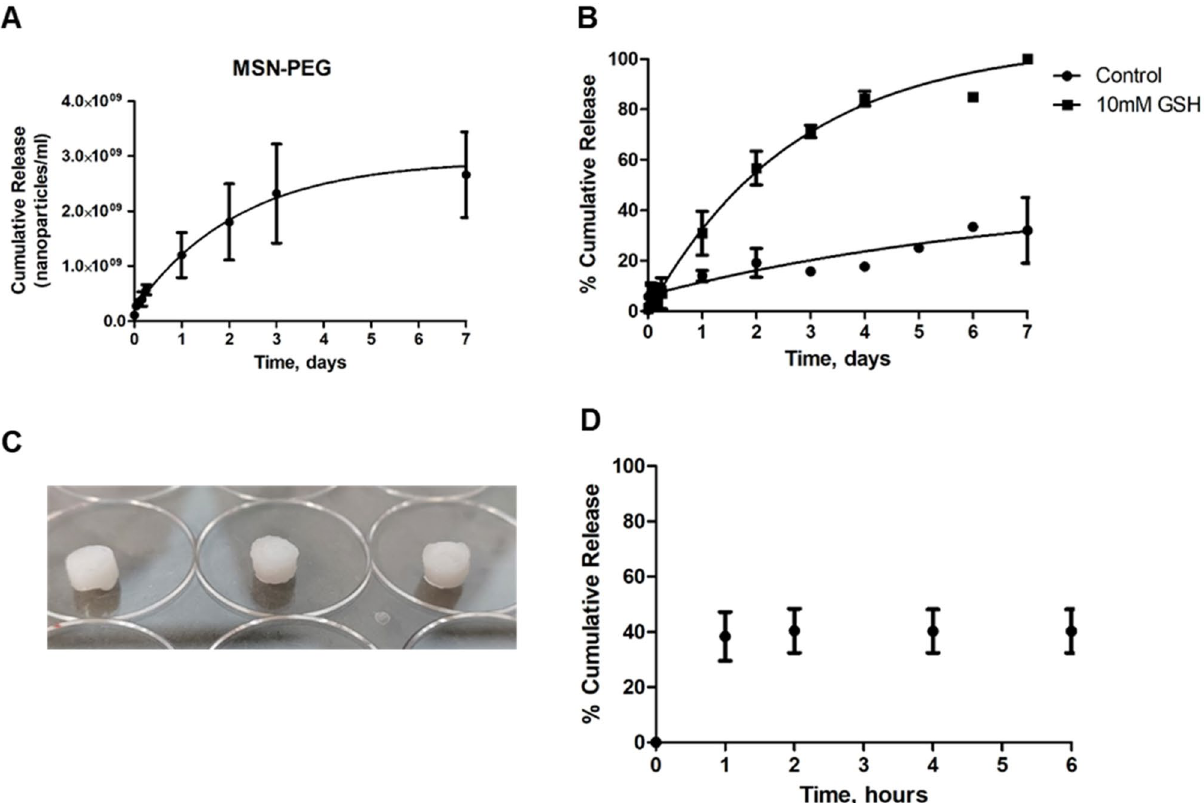
Figure 8. Crosslinked hydrogel release assays. ( A ) MSN-PEG release profile from the CX hydrogel. ( B ) Safranin-O release from MSN-PEG incorporated into CX hydrogel. ( C ) The CX hydrogel (50 µL) was formulated with 150 µg TMZ and 1 mg MSN-PTX-PEG (corresponding to 270 µg PTX) to form GlioGel. ( D ) TMZ release from GlioGel formulation in the first 6